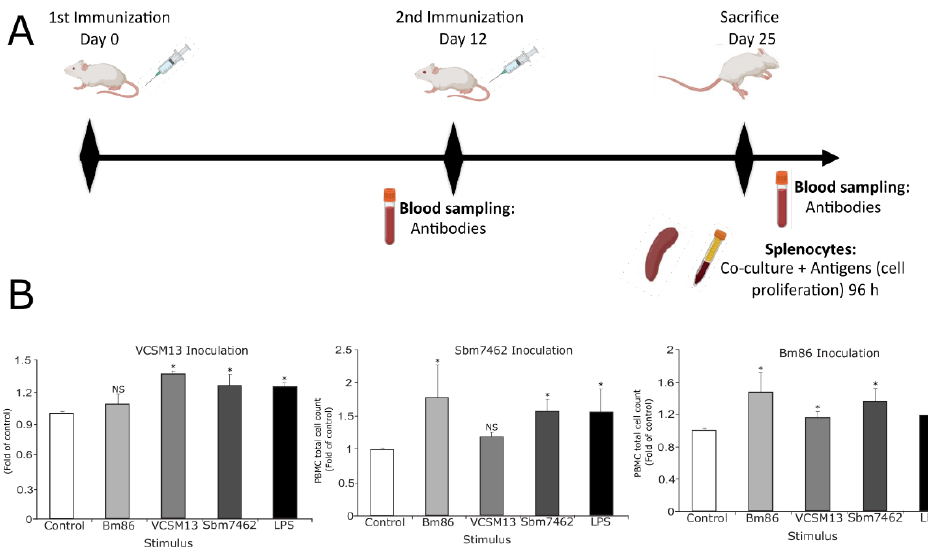
Figure 6. Evaluation of the immune response of the phage-based vaccine in vivo. ( A ). Schematic illustration of the phage immunization and serum sampling schedule. Mice were inoculated subcutaneously with PBS (control group), 1 × 10 12 PFU VCSM13 (control phage), 5 µg commercial antigen BM86, and 1 × 10 12 PFU Sbm7462-phage vaccine equivalent to 5 µg antigen. All treatments were administered in 100 µL of PBS. ( B ) . PBMCs obtained from spleen at day 25 were pulsed with (1) PBS (negative control), (2) 4 × 10 10 PFU of Sbm7462 expressing-phage (equivalent to 0.24 µg of recombinant Sbm7462 peptide, (3) 4 × 10 10 PFU of VCSM13 helper phage (nude phage), (4) 0.24 µg recombinant Bm86 antigen (positive control) and (5) 1 µg/mL lipopolysaccharide (LPS) as positive control. Sbm7462 represent the antigen Sbm7462 displayed on phage. Total cell count was performed after 96 h. n = 6. * p -value < 0.05 compared to control group, NS — not significant.